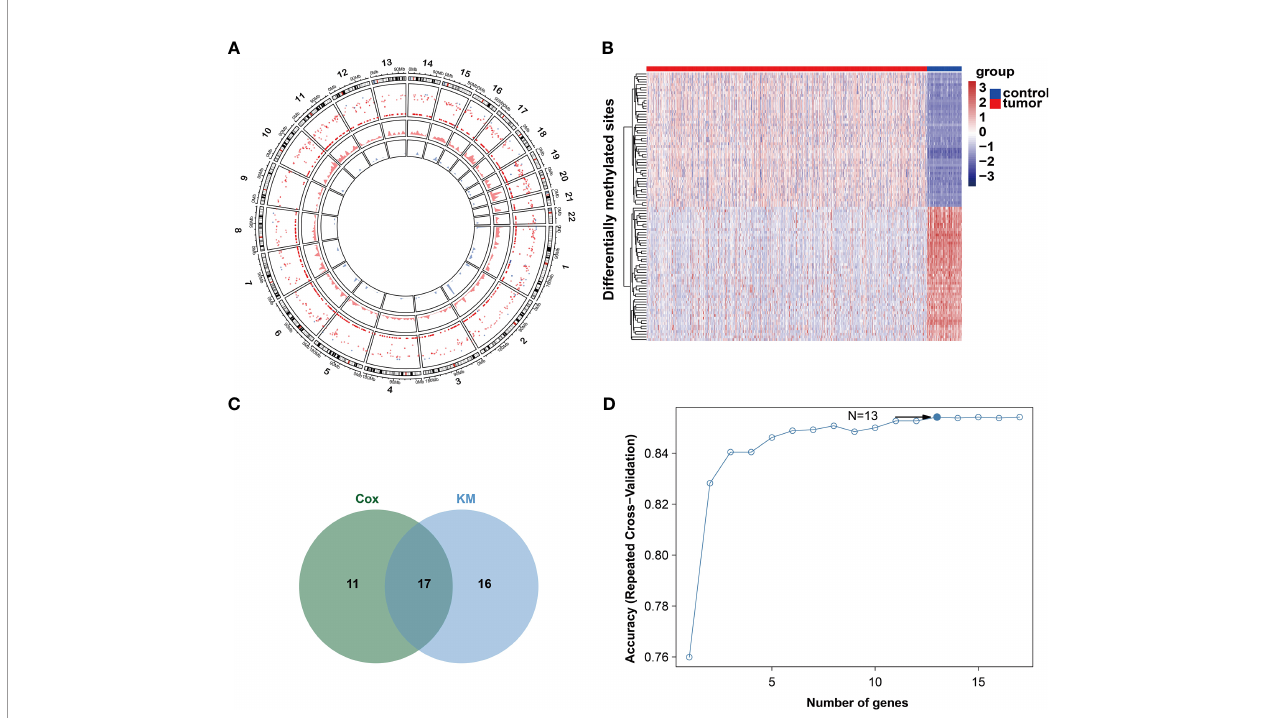
FIGURE 1 | DNA methylation character in gene promoters. (A) Circos analysis of the hyper- and hypo DMSs between tumor and normal groups. The outer layer represents CpG sites heatmap. Red color represents CpG sites are hyper-methylated. Blue color represents CpG islands are hypo-methylated. The middle layer represents density plot of hyper-methylated CpG site. The inner layer represents density plot of hypo-methylated CpG site. (B) Heatmap of top50 hyper- and hypo DMSs. (C) Venn diagram of two methods. (D) Relation between classi fi cation accuracy and selected genes via recursive feature elimination